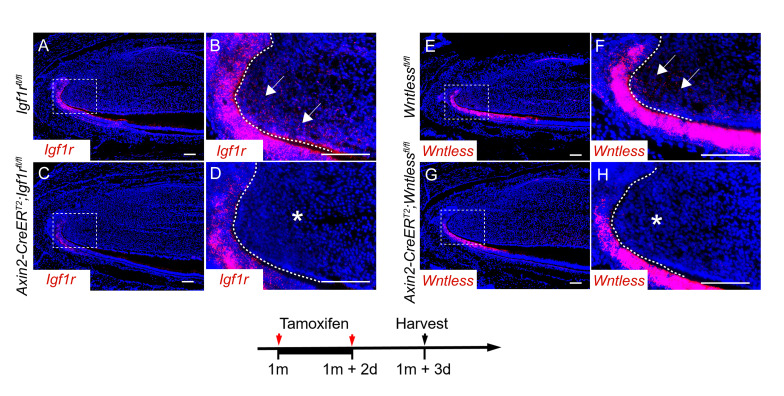
RNAscope staining of Igf1r (A-D) and Wntless (E-H) in control, Axin2-CreERT2;Igf1rfl/fl and Axin2-CreERT2;Wntlessfl/fl mutant incisors three days after tamoxifen induction.Arrow indicates positive signal and asterisk indicates absence of signal.